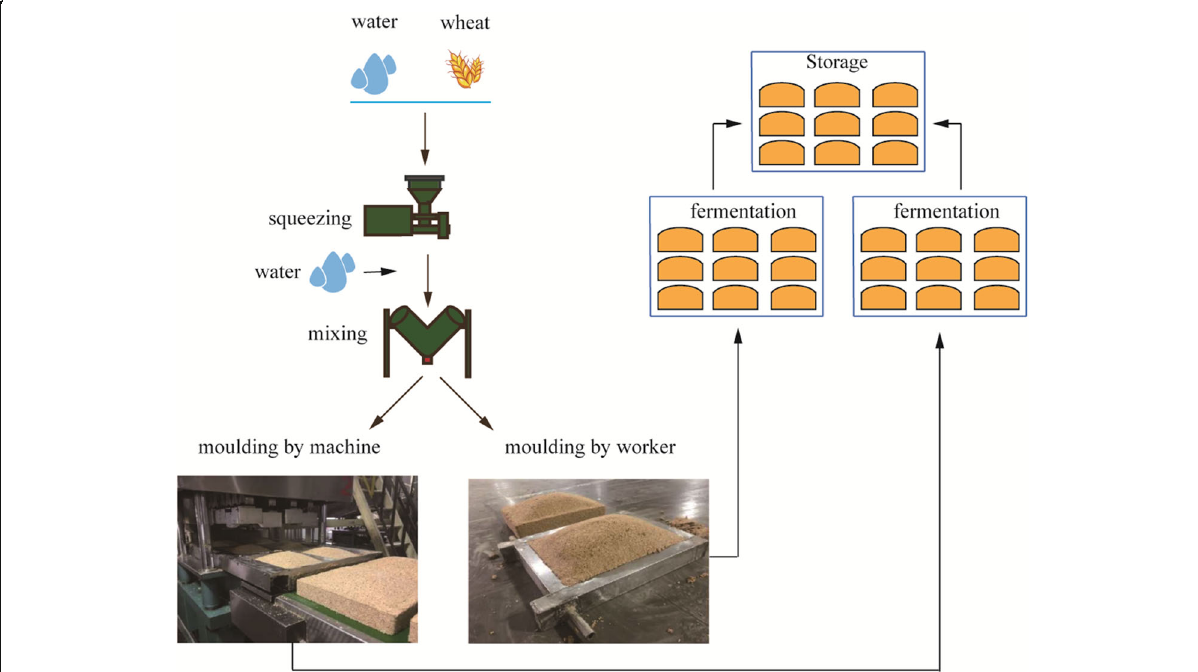
Fig. 1 Process diagram for the production of high-temperature Daqu. Wheat is mixed with 10% (w/w) water and squeezed, and then broken into three or four pieces to adequately release the starch. Then, 40% (w/w) water is added to the wheat, and the mixture is shaped by hand or machine. After the mixture are shaped to bricks weighing 4 to 5 kg each, the bricks are placed in a Daqu room, namely a fermentation chamber, stacked into 4 to 5 layers and fermented for 40 days. Microorganisms, mostly bacteria, are provided by the wheat, water, and air. During the fermentation, workers cover the bricks with rice straw to maintain heat for microbial growth and flavor compound formation. Daqu is turned over to lower the temperature, involving the first turning of Daqu bricks (the 7th day of fermentation) and second turning of Daqu bricks